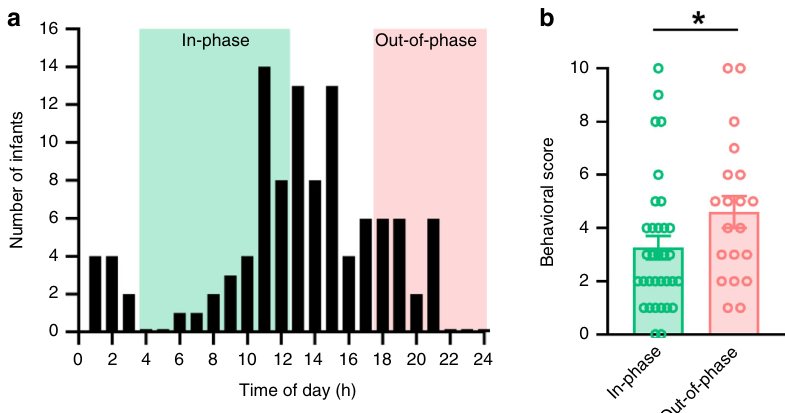
Fig. 6 Preterm infants who received antenatal GCs out-of-phase show altered behavior. a Distribution of the number of 5-year-old preterm infants included in the analysis. Data were collected in three centers included in the German Neonatal Network; Lübeck, Cologne and Essen. Depending on the difference (in hours) between the time of maternal physiological cortisol peak (estimated at 8:00, 74 ) and the time of antenatal betamethasone injection, preterm infants were divided into two groups; the in-phase group, injected between 4:00 and 12:00 (green shading) and the out-of-phase group, injected between 18:00 and 0:00 (pink shading). b A compound behavioral score (0 to 10) was used to quantify stress compensation capacity, infants with high score are reported to have more features indicating poor stress compensation capacity 51 . In total, 53 behavioral scores of 5-year-old preterm infants from the three centers were included in the in-phase ( n = 33) and out-of-phase groups ( n = 20) (i.e. 54 children out of n = 107 belong to the middle group whose mothers were injected from 12:00 to 18:00 and from 0:00 to 4:00). Data are expressed as means ± SEM; *indicates p = 0.031 [ β = .65, t (49) =